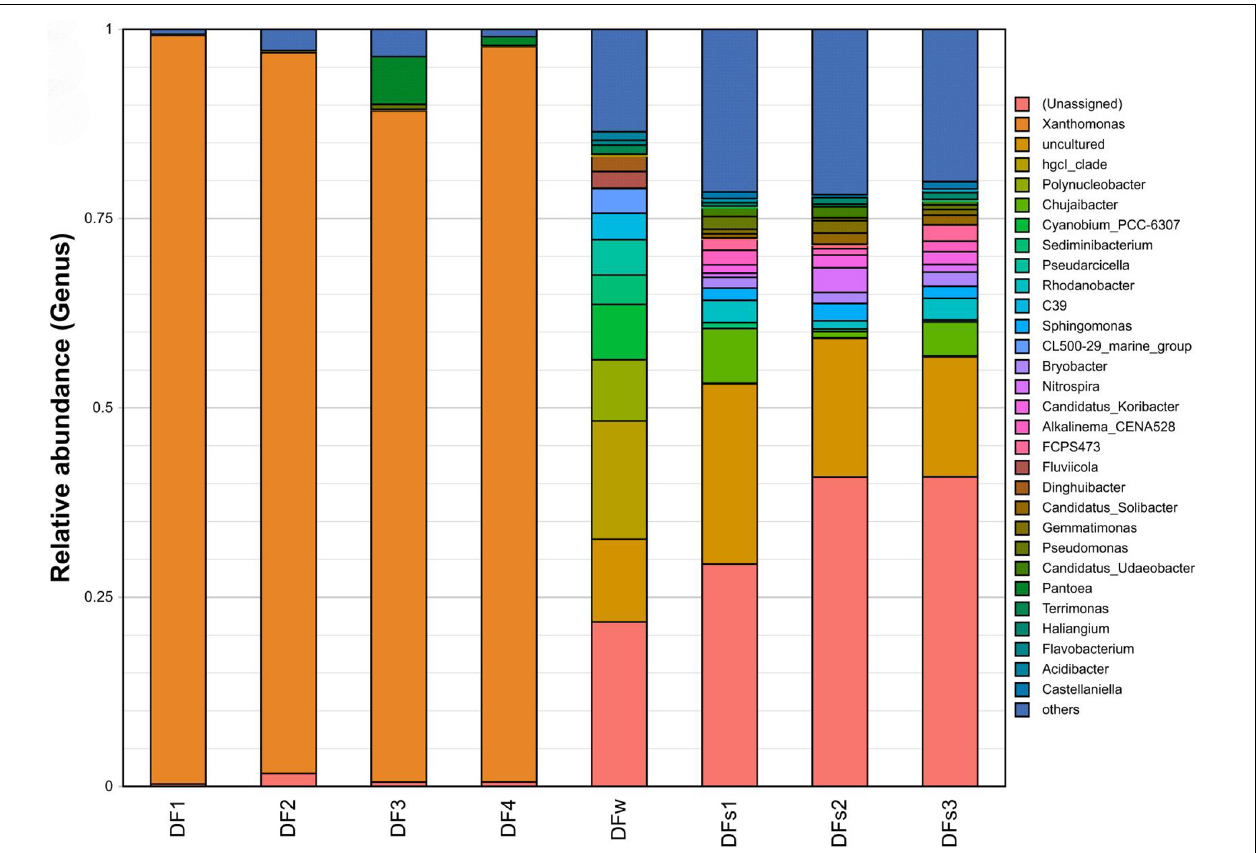
FIGURE 2 | Relative abundance of the top 30 16S rDNA-based operational taxonomic units (OUTs) at the genus level. Samples are labeled to indicate their source of collection: DF1 to DF4 indicate four leaf samples of diseased plants from Dafen Zone. DFs1 to DFs3 indicate three rhizosphere soil samples of diseased plants from Dafen Zone. DFw indicates nearby irrigation water of diseased plants from Dafen